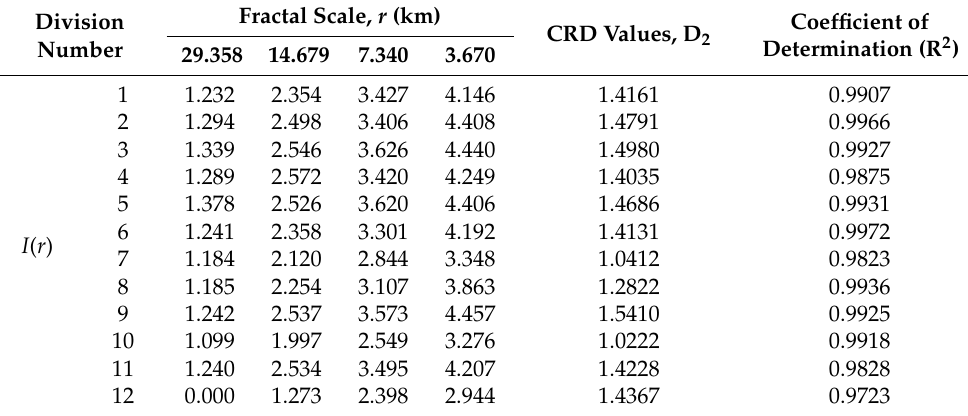
Table 5. Statistical table of division for the correlation dimension (CRD) calculation